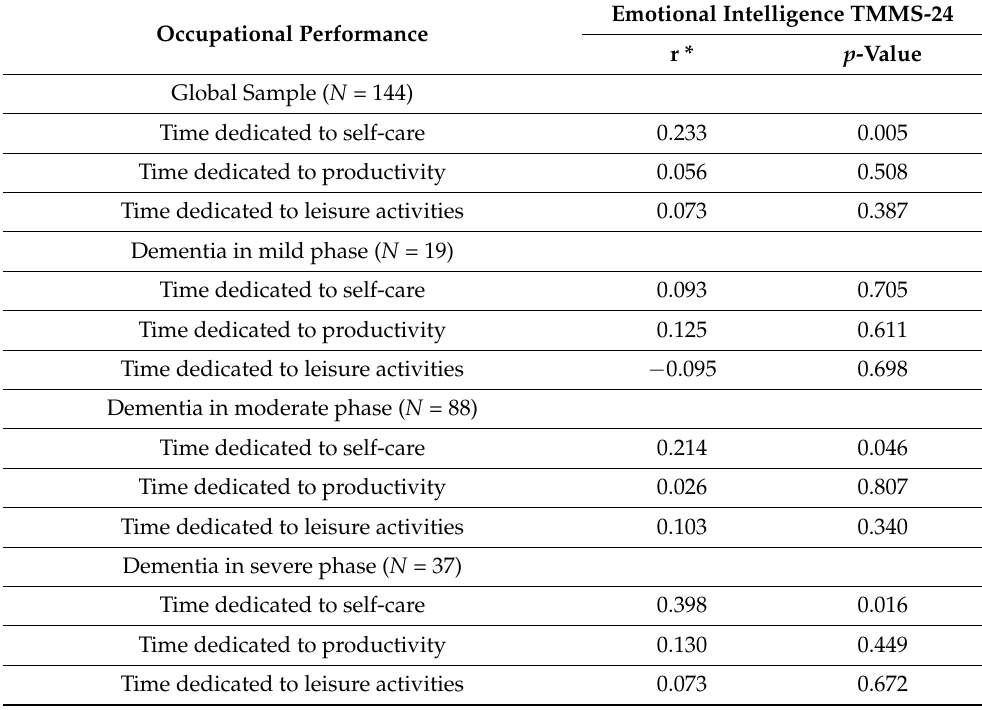
Table 5. Relationship between emotional intelligence and occupational performance in caregivers of patients with dementia. Global sample and differentiation according to the patient’s dementia